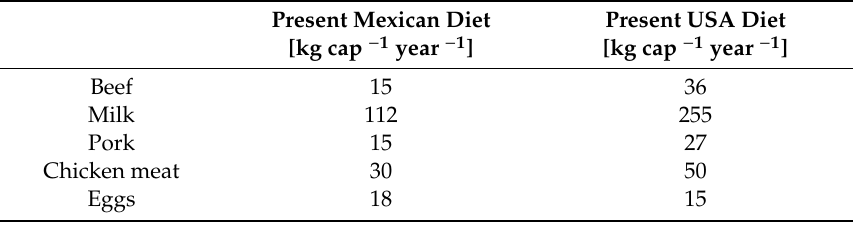
Table 6. Animal products consumption per capita for the present average Mexican diet and the USA diet. Source: Food Balance Sheets, values of food supply per capita in 2013 from FAO